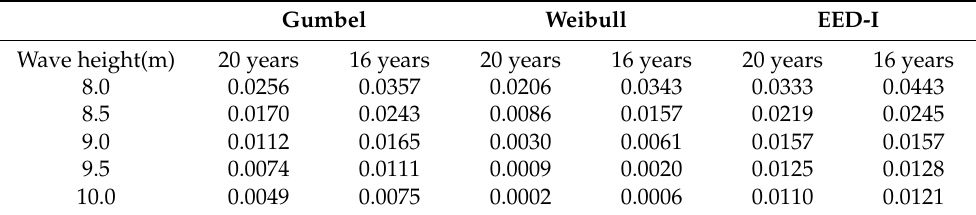
Table 3. Comparison of fitting results of different probability density functions to wave height tail data.